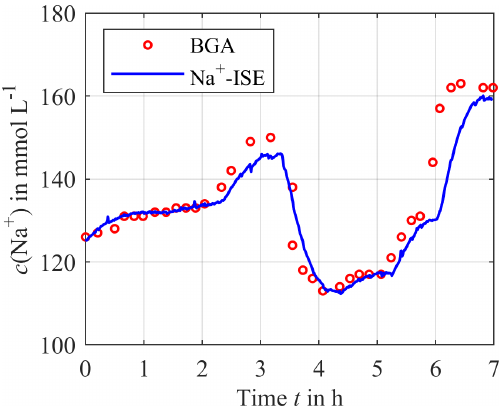
Figure 4. Schematic depiction of the test bench using human packed red blood cells as a test medium. Blood samples are drawn at regular intervals via the three-port valve and are then analyzed by a standard blood gas analyzer (BGA) and in the laboratory. The BGA values serve as a reference for the ion-selective electrodes to determine the electrolyte concentration, and the laboratory values serve as a reference for the urea sensor.